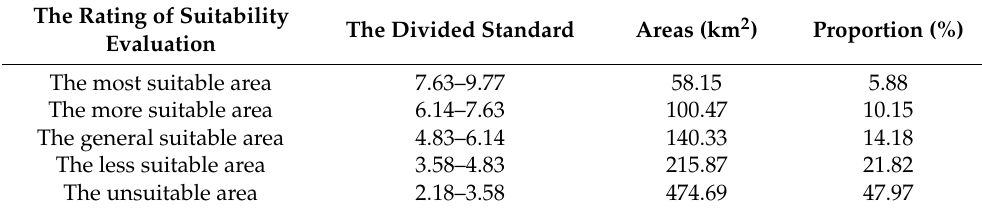
Table 2. Xifeng’s township construction land suitability of hierarchies and area